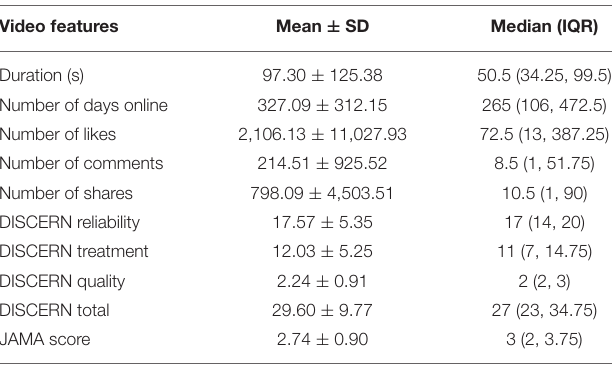
TABLE 1 | General features of included